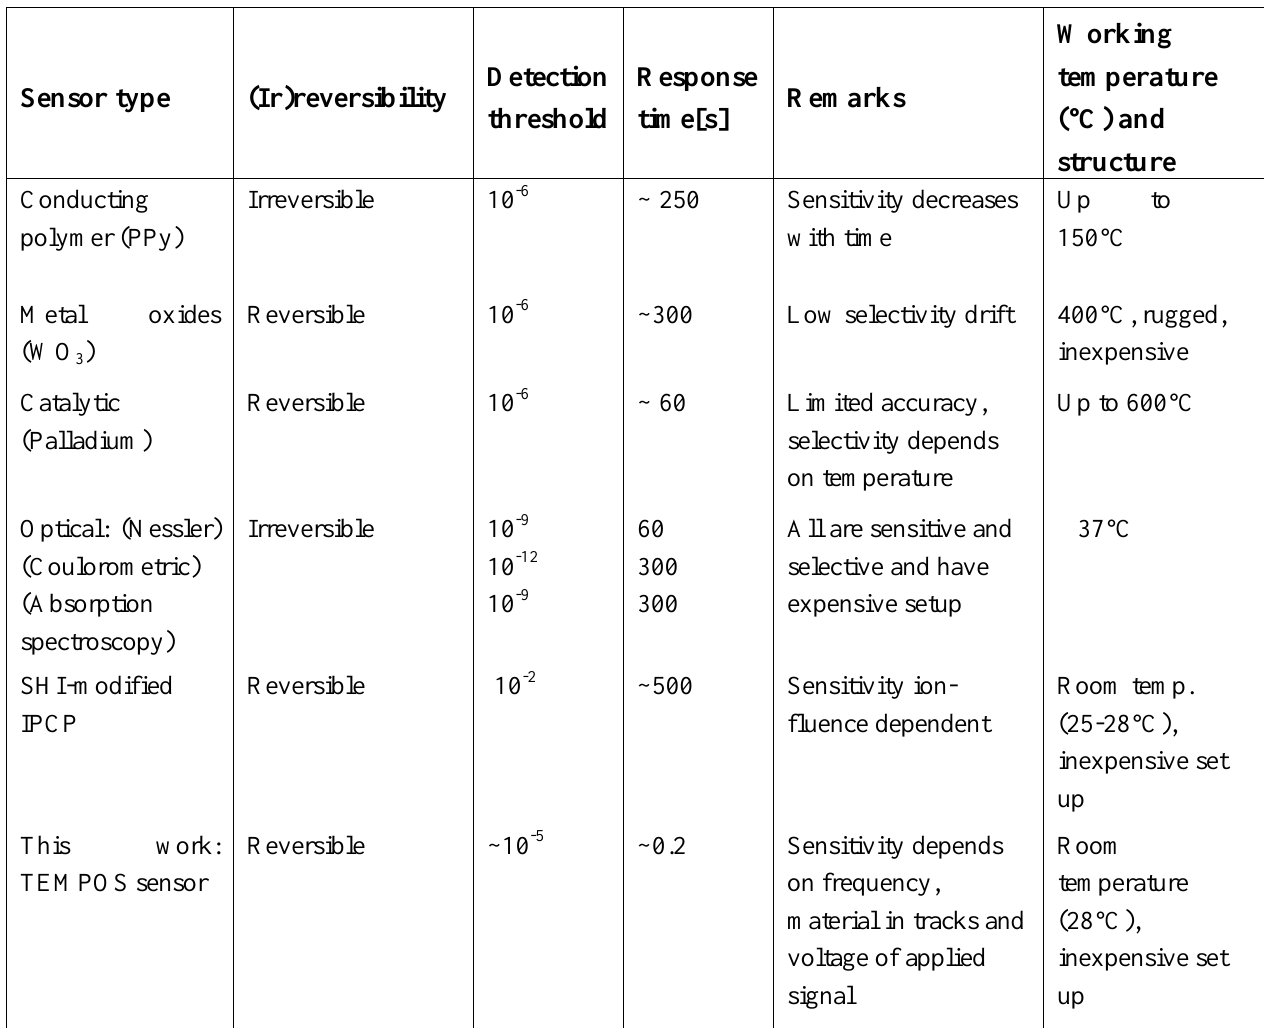
Table 2 . Parameters of different types of ammonia sensors and sensor